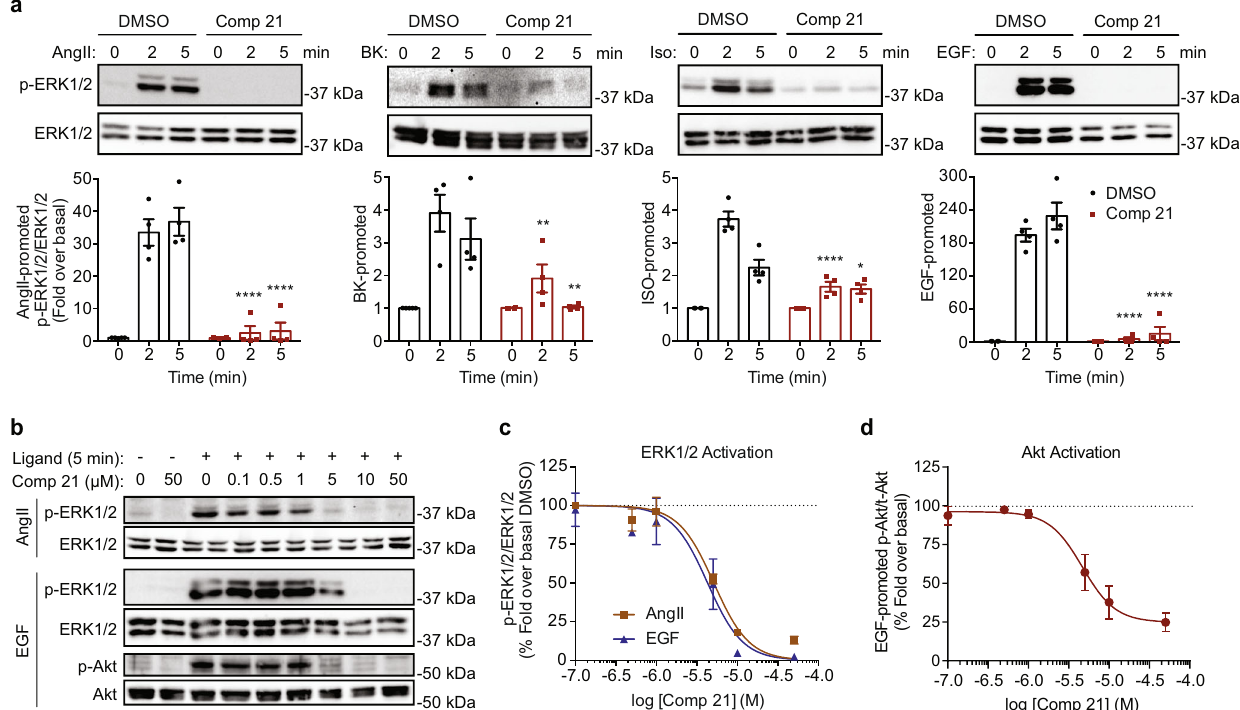
Fig. 3 Compound 21 inhibits receptor signaling. a Western blots of ERK1/2 phosphorylation kinetics in cells mediated by AT1R, B2R, β 2 AR, and EGFR in absence (DMSO, black open bars) or presence of 21 (50 μ M, red open bars). Data were quanti fi ed as p-ERK1/2 over ERK1/2, normalized to basal (0 min), and compared to DMSO. Data are presented as mean values± SEM, n = 4 biologically independent experiments, * p < 0.05, ** p < 0.01, **** p < 0.0001, two- way ANOVA with Bonferroni correction. b – d Western blots and quanti fi cation of AT1R- and EGFR-mediated ERK1/2, and EGFR-mediated Akt activation in the absence (DMSO) or presence of 21 (at indicated concentrations). Data were quanti fi ed as AngII- (closed red squares and line) and EGF-mediated (closed blue triangles and line) c p-ERK1/2 over ERK1/2, and EGF-mediated (closed red circles and line) d p-Akt over Akt, respectively, and normalized as fold over basal, percent compared to DMSO (dotted lines). Data are presented as mean values ± SEM, n = 3 biologically independent experiments. Source data are provided as a Source Data fi